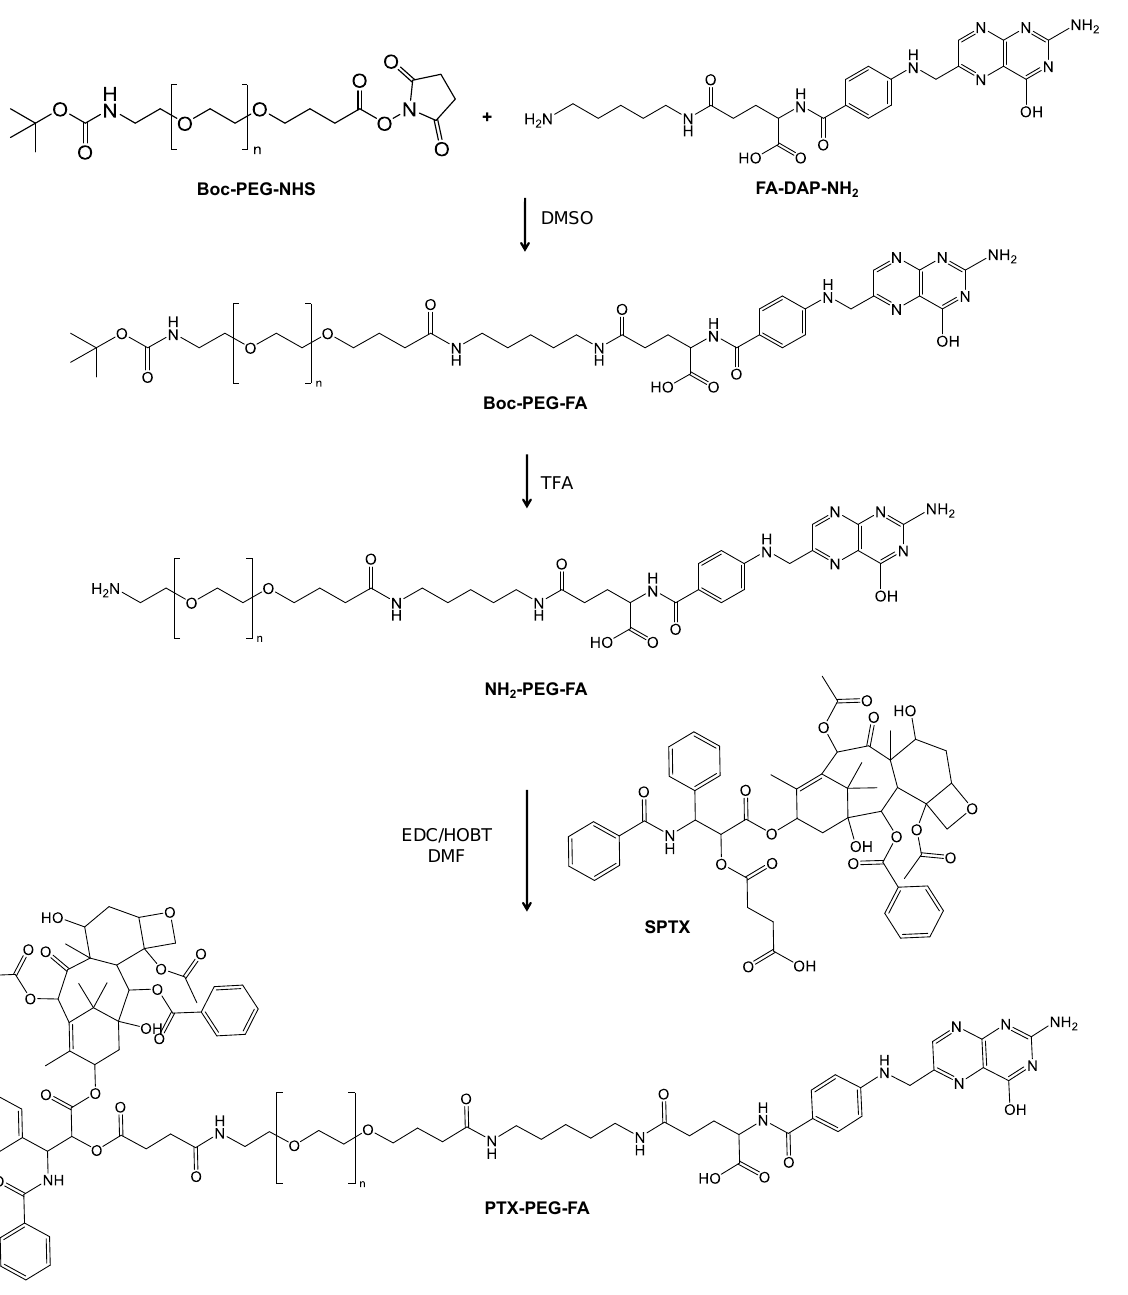
Figure 1. Synthesis of PTX-PEG-FA.